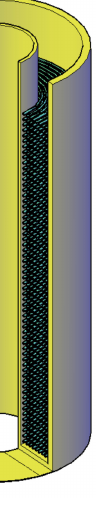
Figure 16. View of LHTES container geometry with capillary mat [17]. Table 5. Summary of principal geometrical and thermo-physical properties of the LHTES